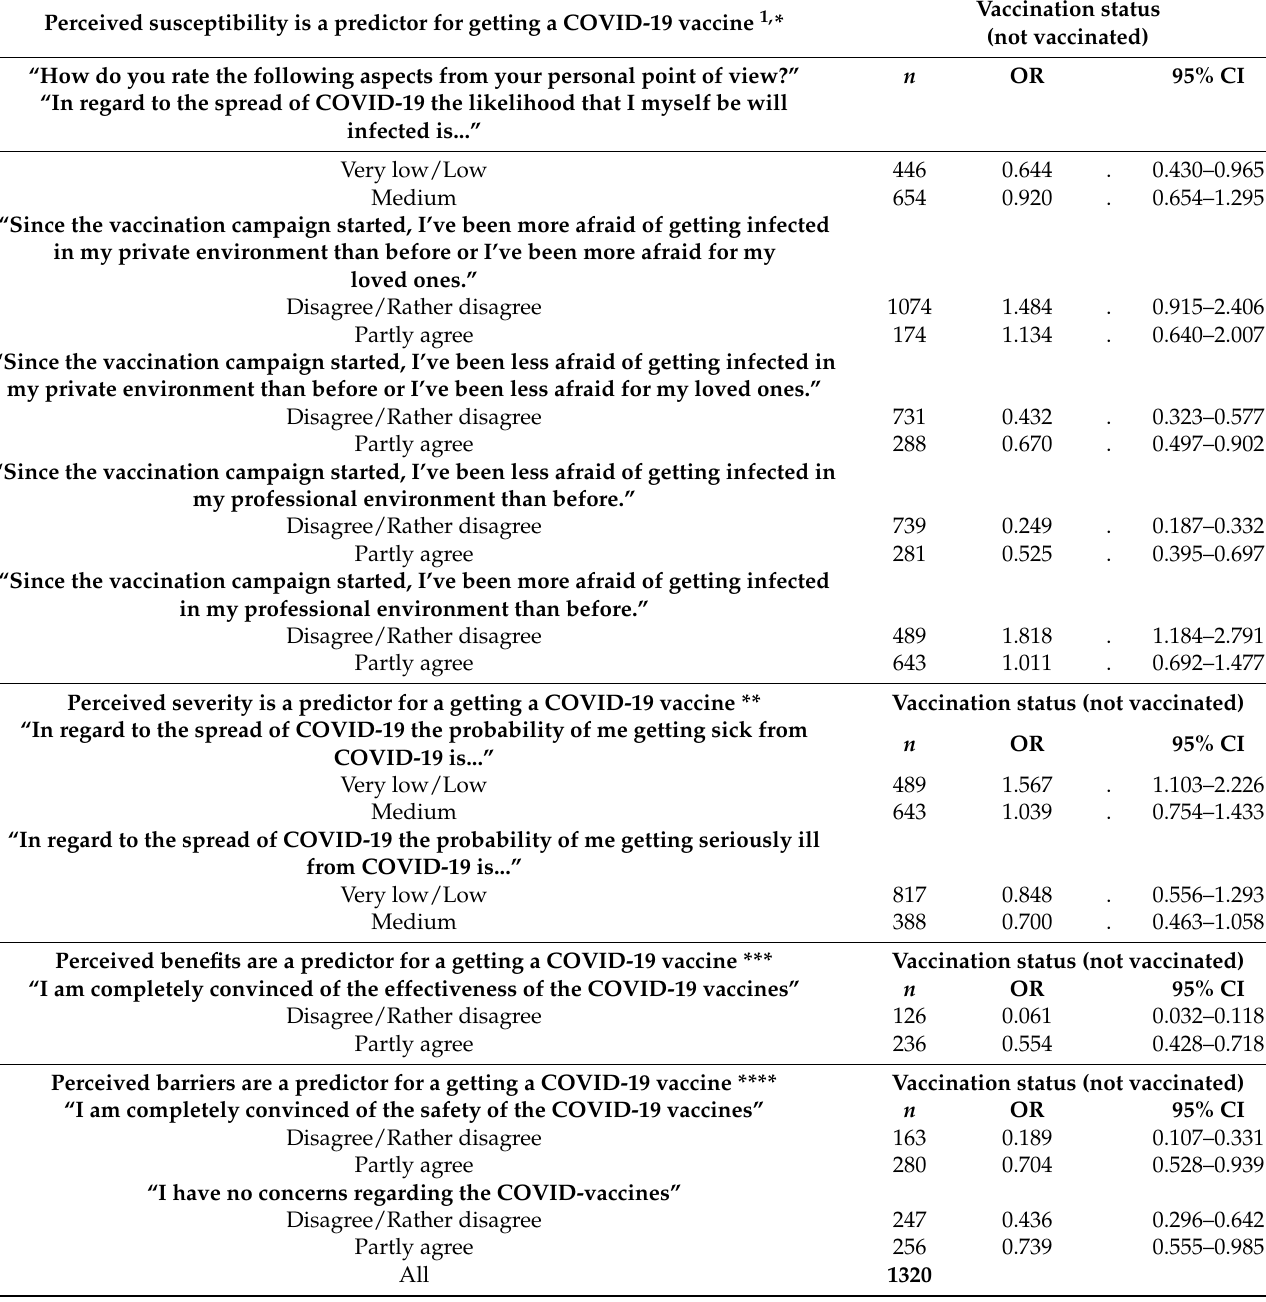
Table 7. Binomial logistic regression models with the Health Belief Model factors associated with intent to receive a COVID-19